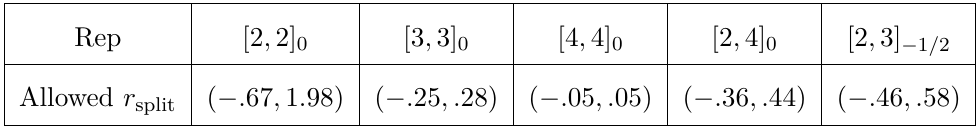
for the given range of f . The 2 i f i Q max i